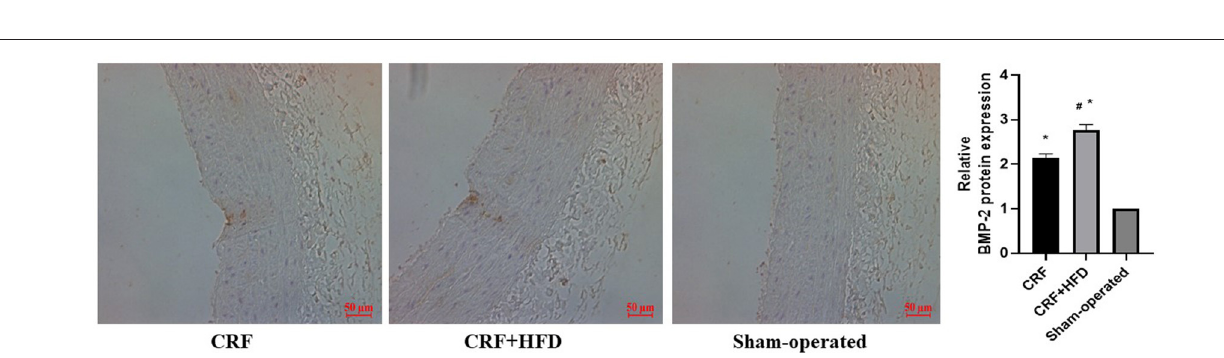
BMP-2 mRNA and protein in the β -GP group ( p >